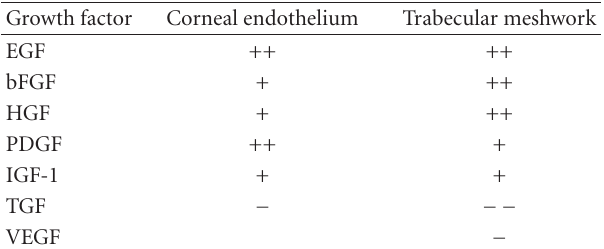
Table 1: The influence of growth factors on CE and TM cell prolif-